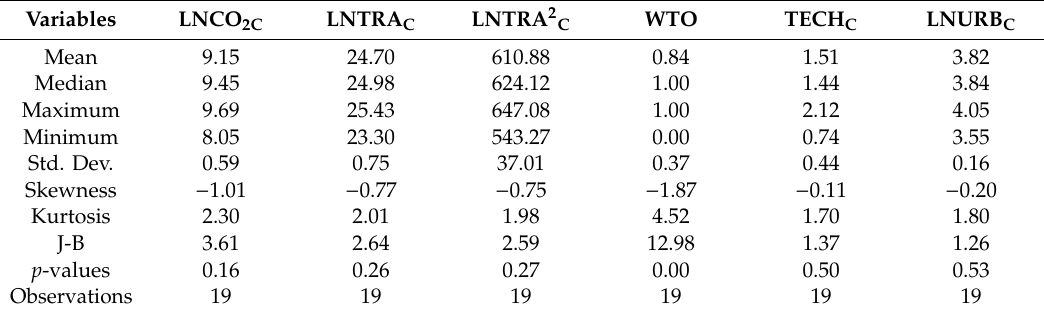
Table 2. Descriptive statistics results for